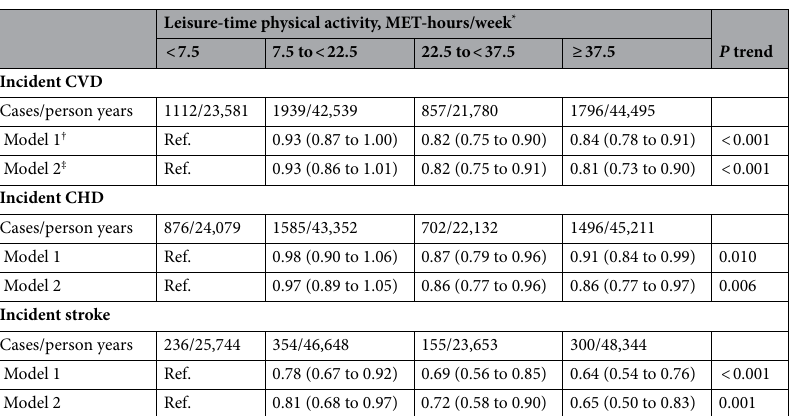
Table 2. The association of leisure-time physical activity with cardiovascular disease. *< 7.5, 7.5–22.5, 22.5–37.5, and ≥ 37.5 MET-hours/week represented < 1, 1–3, 3–5, and ≥ 5 times of the minimum recommended LTPA level, respectively. † Adjusted for age and sex. ‡ Additionally adjusted for education, smoking status, alcohol intake, consumption of food (meat, vegetables, and fruit), hypertension, hyperlipidemia, diabetes, BMI, MET-hours/week, total sedentary time, and family history of CVD.